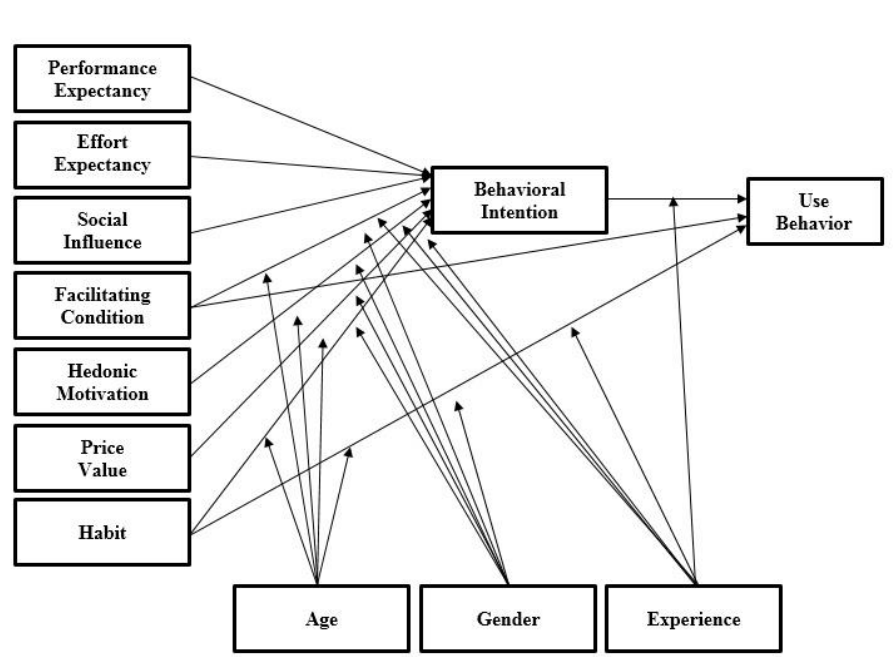
Figure 1. Research Model UTAUT 2 (Venkatesh et al.,